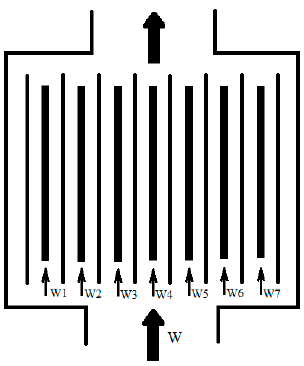
Figure 1. Schematic diagram of closed parallel channel.